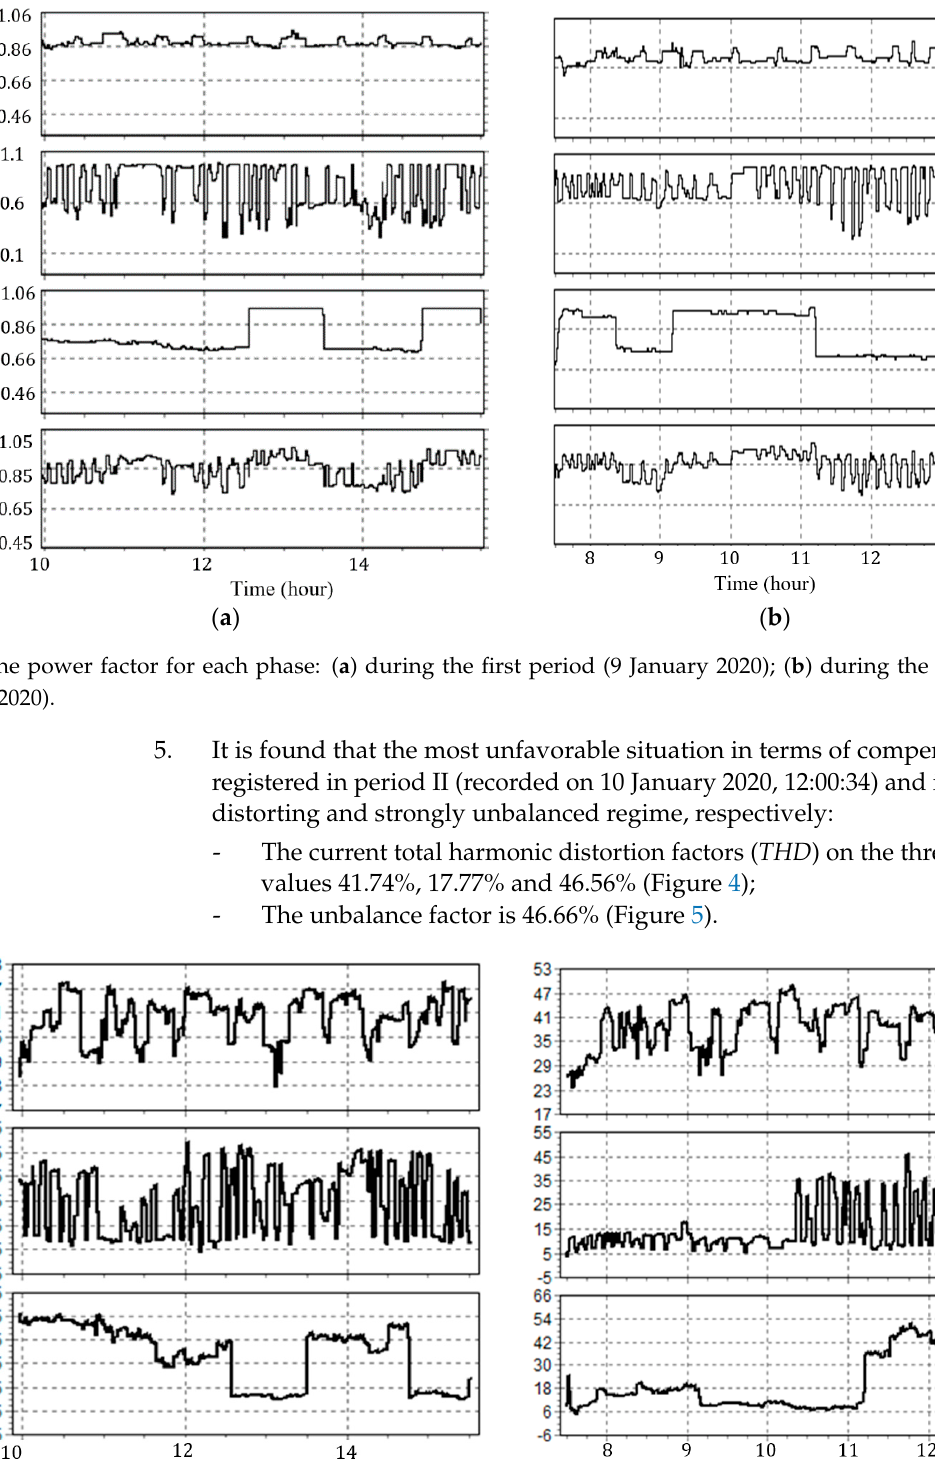
( b ) Figure 5. The load unbalance reflected by the neutral wire current: ( a ) during the first period (9 January 2020); ( b ) during the second period (10 January 2020). 3. Experimental Setup The analysis shows that in order to improve the power quality in PCC, three goals must be achieved: compensation of the distortion power, compensation of the reactive power and compensation of the load unbalance. To achieve them, a four-wire three-leg shunt active power filter was designed, the connection with the transformer neutral point being obtained by dividing the compensation capacity. The main parameters of the power system are included in Table 1. Table 1. The main parameters of the system. Items Values Supply Transformer